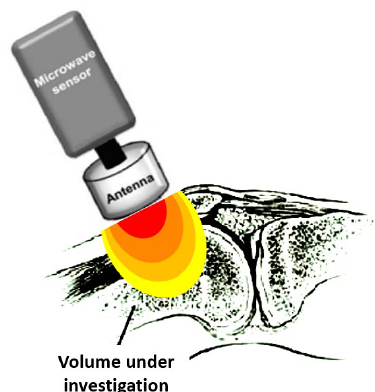
Figure 1. The measured temperature is the average temperature within the volume in the vicinity of the antenna, weighted according to its sensitivity pattern (lobe). The temperature of the dark (red) area volume is of more weight in the measurement than that of the volume in the light (yellow) area. Modified from Zampeli et al. [13].